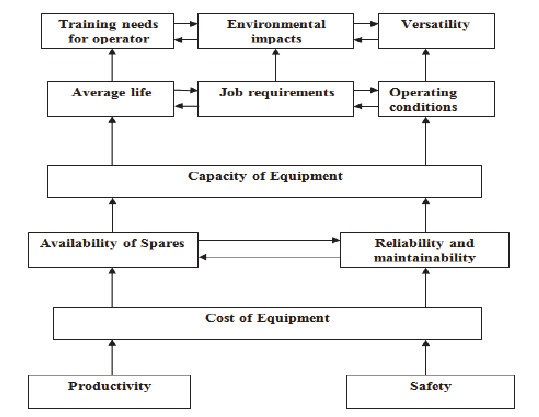
Fig. 1. Driver – dependence diagram Fig. 2. ISM based hierarchy